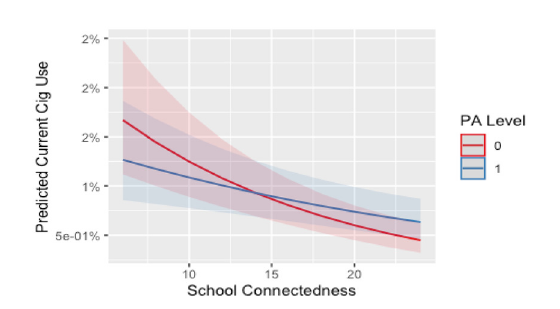
FIGURE1 Interaction between school connectedness and MVPA level on current cigarette use for males. 0, no; 1, yes. PA level, meeting moderate to vigorous physical activity level based on Canadian guidelines. Line and shade, mean and SE.